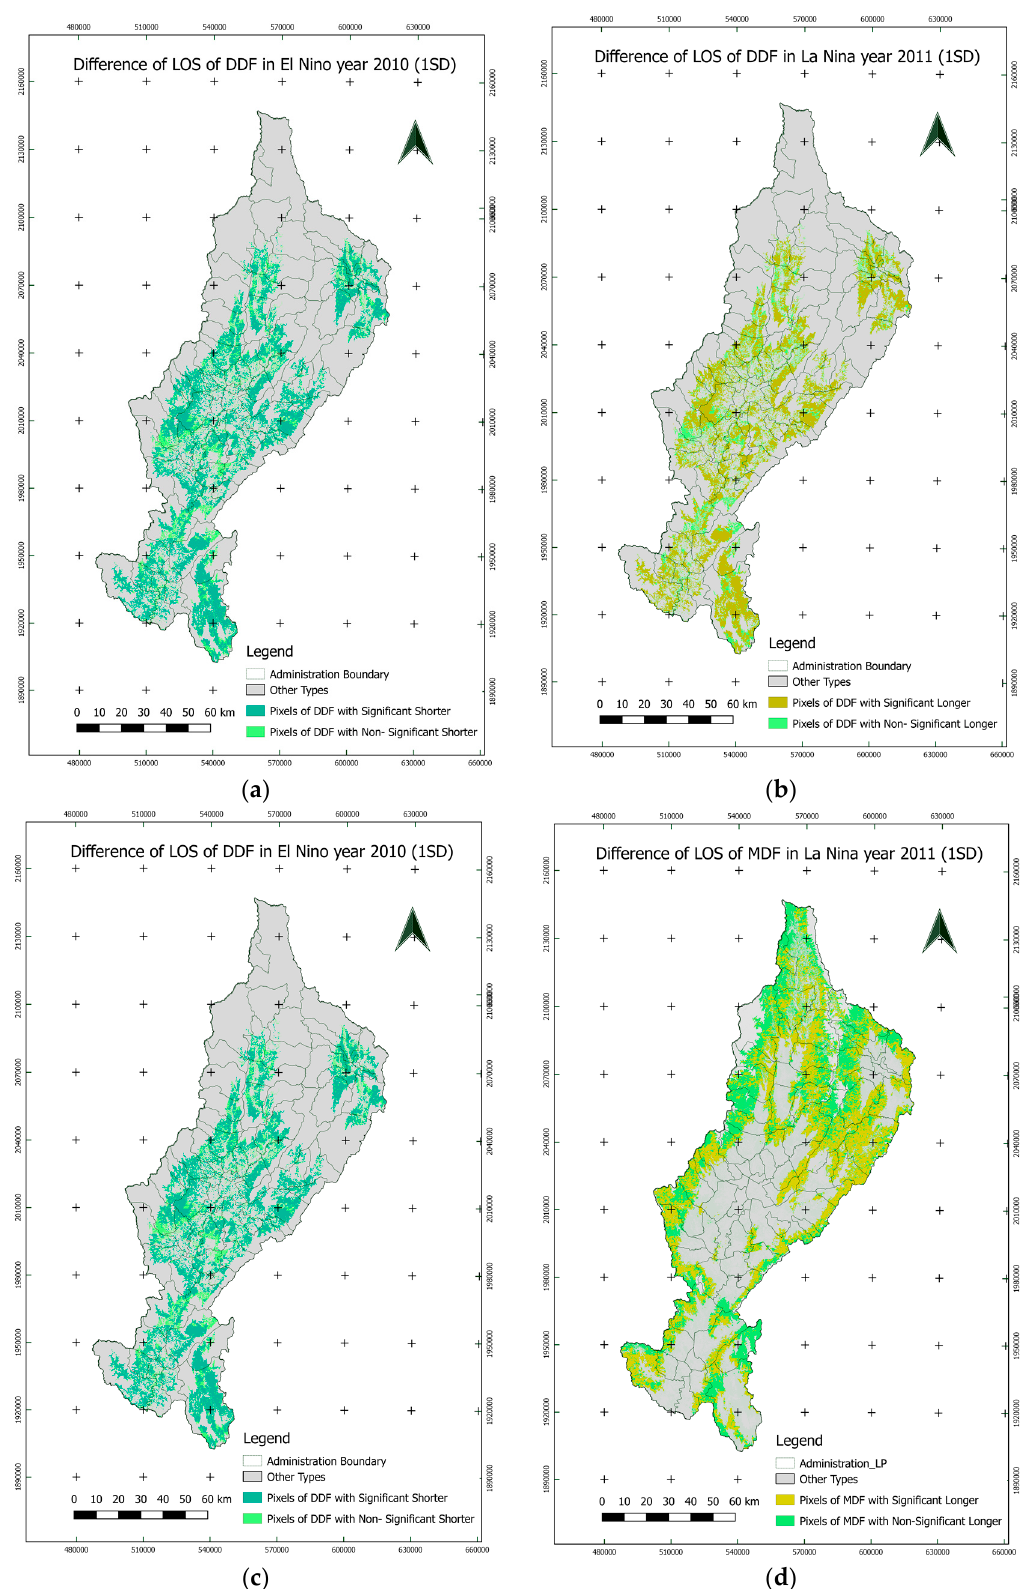
Figure 13. The spatial different of LOS DDF and LOS MDF between neutral year to El Niño ( a , c ), La Niña ( b,d ) respectively. The significant difference is based on 1SD.